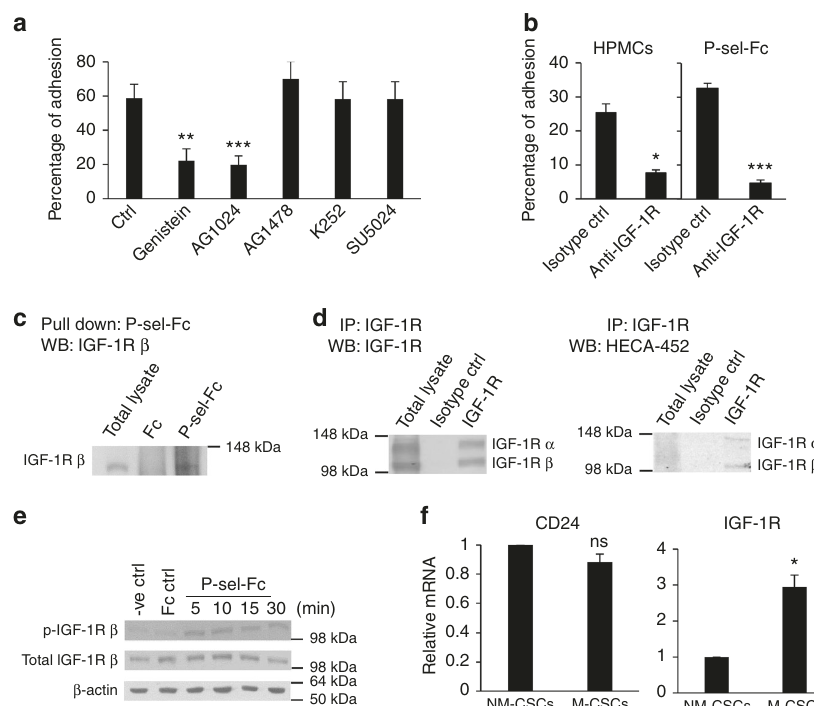
Fig. 5 The sLe x -containing P-selectin ligand is IGF-1R-dependent. a , b Percentage of adherent M-CSCs after treatment with RTK inhibitors on HPMCs. Genistein, general RTK inhibitor; AG1024, IGF-1R inhibitor; AG1478, EGFR inhibitor; K252a, c-Met inhibitor; SU5402, FGF-1R inhibitor. n = 39, 36, 56, 20, 24, 24. b Percentage of M-CSCs adhesion to HPMCs or P-selectin-Fc after anti-IGF-1R treatment. n = 45/71, 70/72. Data (mean ± SEM) from one of three independent experiments, chi-square test a , b . c Presence of IGF-1R in the M-CSCs protein lysate pulled down with P-selectin-Fc. d Detection of HECA-452 antigen on IGF-1R of M-CSCs. e P-selectin binding on M-CSCs activates the phosphorylation of IGF-1R. f mRNA expression of CD24 (left) and IGF-1R (right) in M-CSCs and NM-CSCs. Data (mean ± SEM) from three biological replicates, n = 3, unpaired Student t test. ns, not signi fi cant; * P < 0.05; ** P < 0.01; *** P <